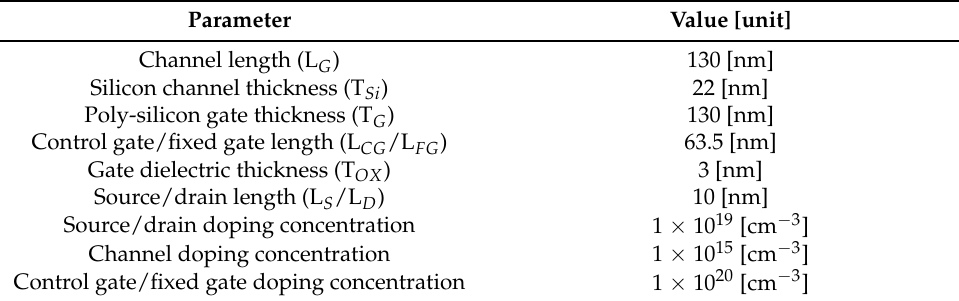
Table 1. Default parameters of the FBFET simulation structure. Parameter Value [unit] Channel length (L G )